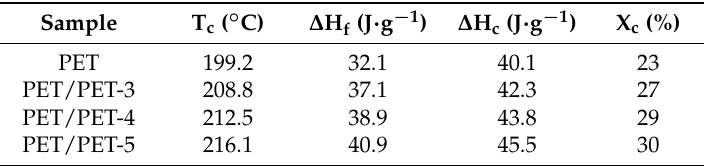
Table 1. Thermo-performance parameters of the